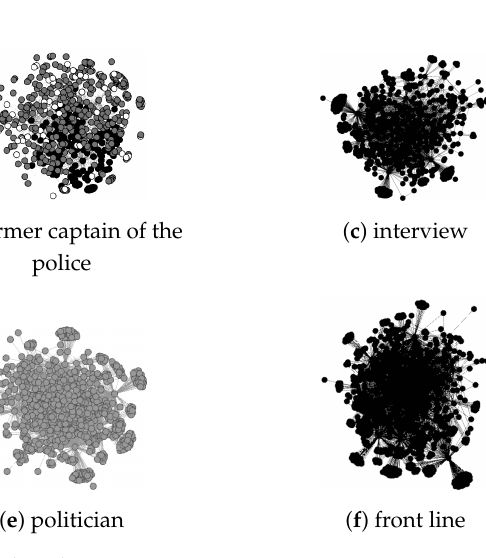
Figure 9. Final network of the six tweets